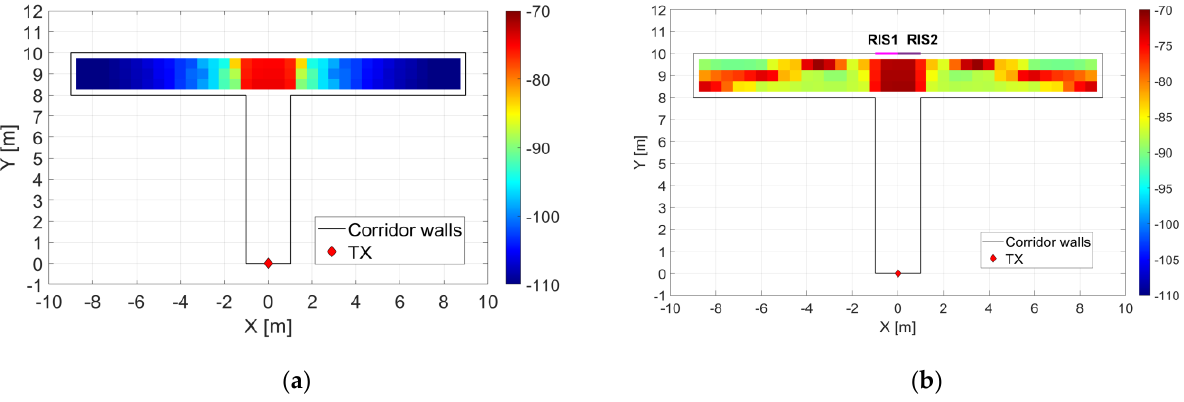
Figure 9. Comparison of coverage in a T − shaped corridor scenario: ( a ) without RIS usage; ( b ) by employing two RISs placed in the center of the intersection with symmetric configuration (anomalous reflection angle = ±80°).